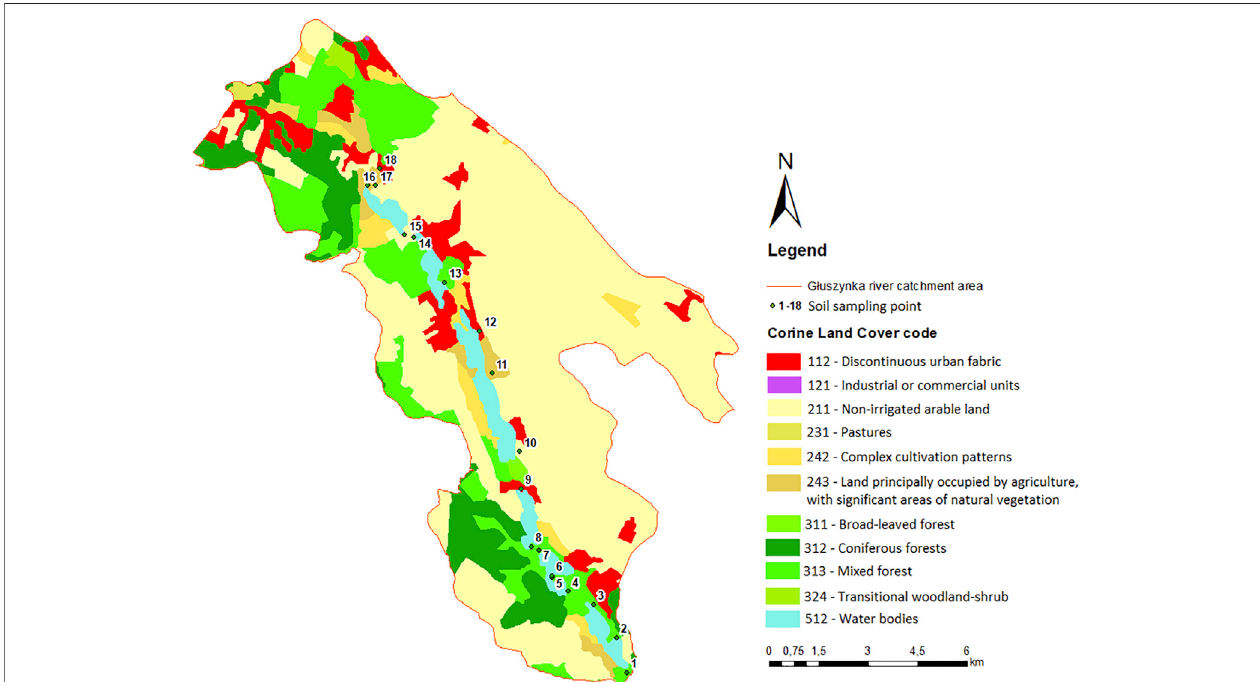
FIGURE 2 | Structure of land use of the G ł uszynka river catchment area (source: CLC 2018).